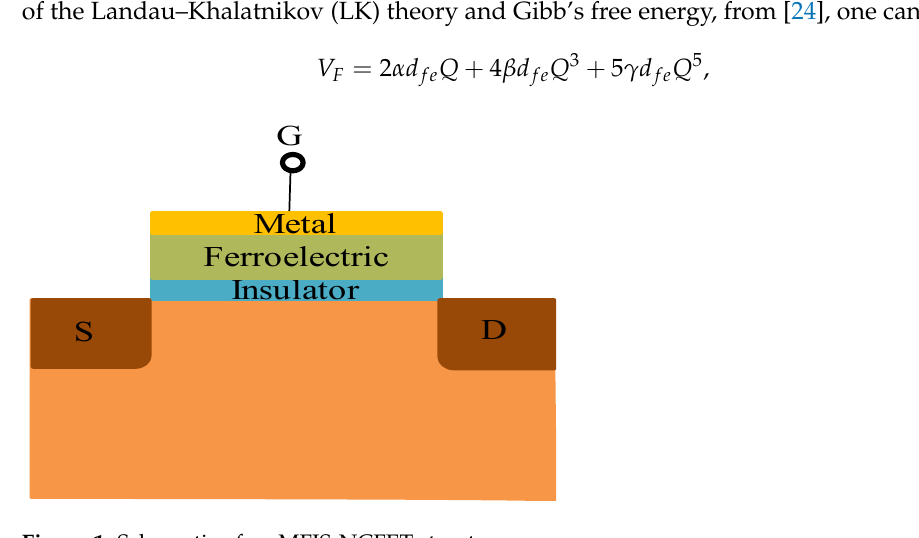
Figure 1. Schematic of an MFIS-NCFET structure.